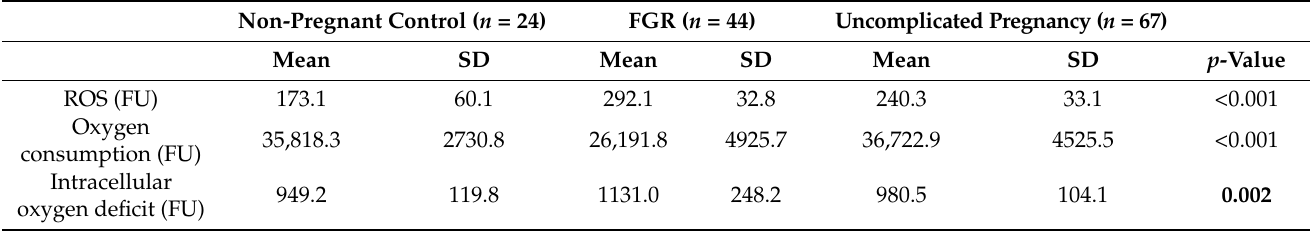
Table 2. ROS levels, oxygen consumption, and intracellular oxygen deficit in the platelets isolated from different groups of women.